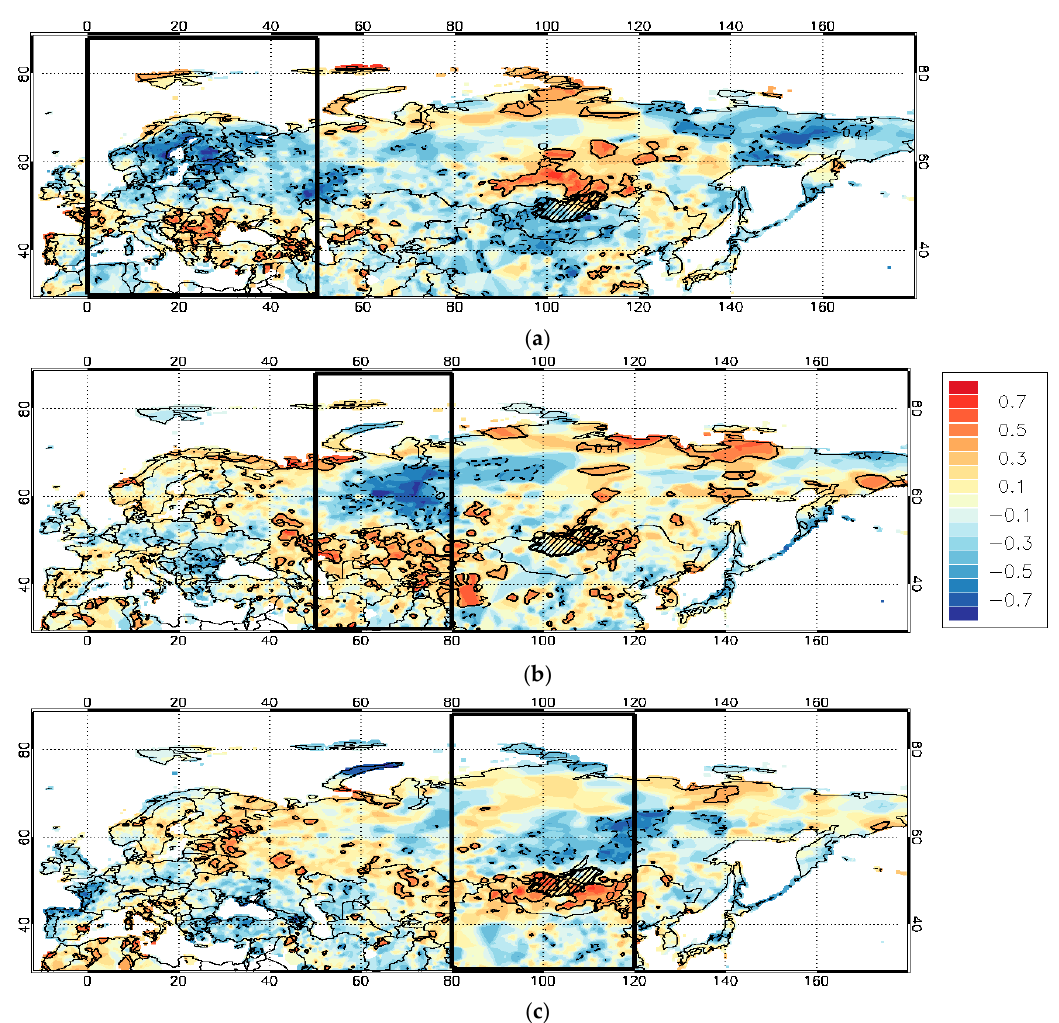
Figure 8. Correlation coefficients of E ( a ), UWS ( b ), ESM-BF ( c ) and normalized precipitation for 1979–1995. The solid black line and dashed line areas indicate the 90% confidence level the positive and negative coefficients of correlation, respectively. The hatched area shows the Selenga Basin.